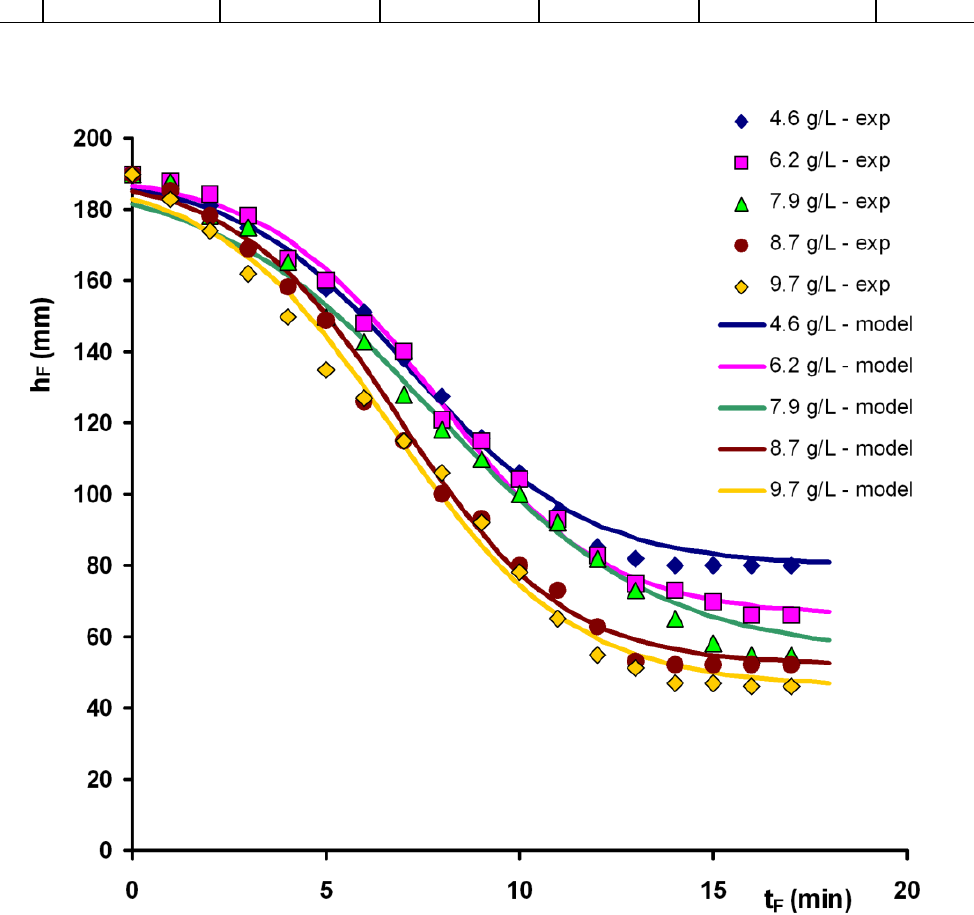
Fig. 7. Foam decay – effect of beer CO 2